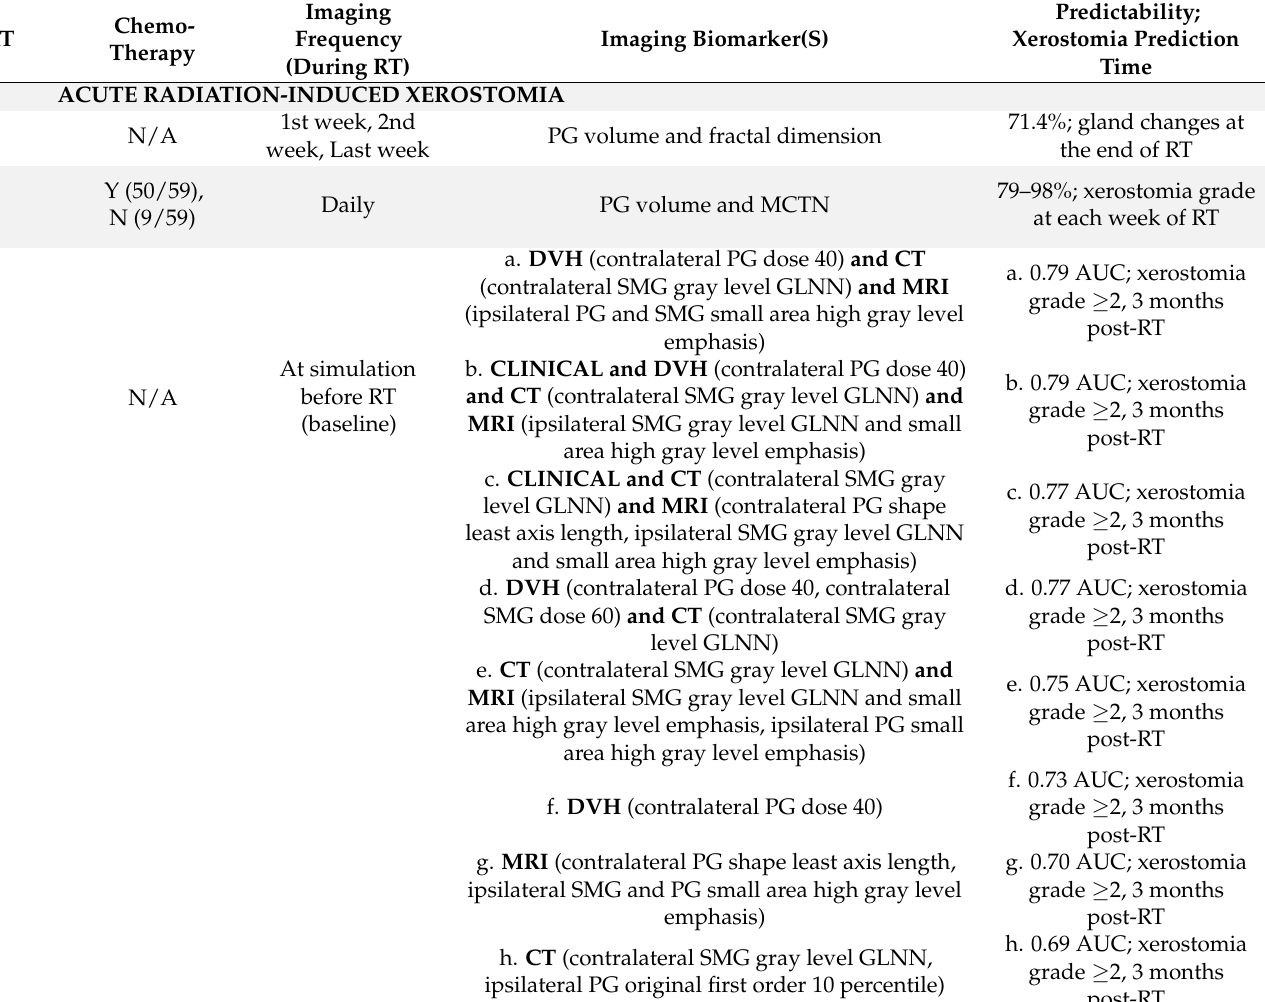
Table 1. Imaging biomarkers for acute and chronic radiation-induced